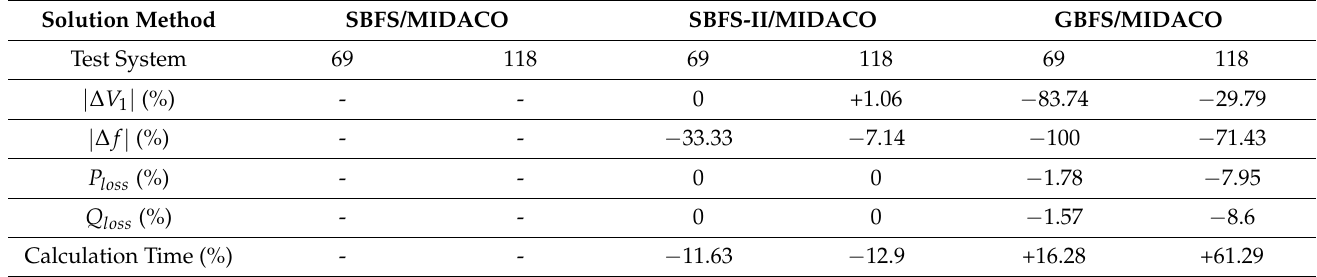
Table 10. Percentage difference in the multi-objective results for both test systems.